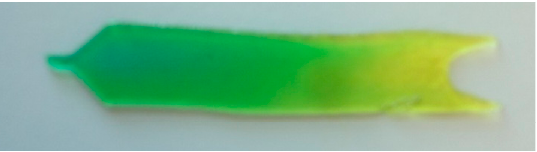
Figure 1. Demonstration of colormetric gradient in a polyethylene glycol hydrogel. Adapted with the permission from [73]. Copyright 2015 Elsevier.